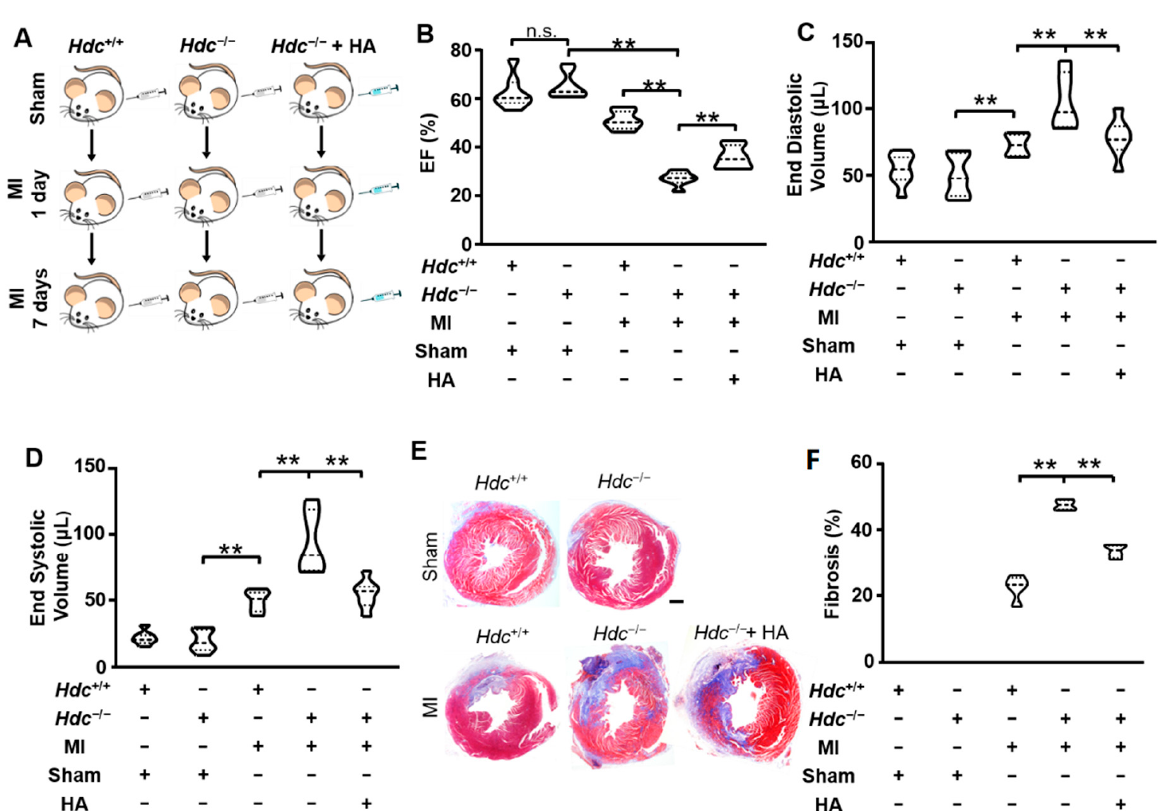
Figure 1. Hdc deletion reduced heart function at day 7 after MI. ( A ) Experimental design for transcriptomic analysis of Hdc +/+ and Hdc − / − mice, with or without histamine (HA, 4 mg/kg) treatment, at 0, 1, or 7 days post myocardial infarction surgery. n = 3 per time point. ( B – D ) Quantitative analysis of left ventricle ejection fraction ( E , F ), end diastolic volume and end systolic volume of mice at the 7th day post MI surgery. n = 5. ( E ) Representative figures of Masson’s trichrome staining of cardiac mid-sections from Hdc +/+ and Hdc − / − mice, with or without histamine. The myocardial fibers and collagen are colored blue. Quantitative analysis of the percentages of fibrosis is shown on the right. ** p < 0.01, n.s., no